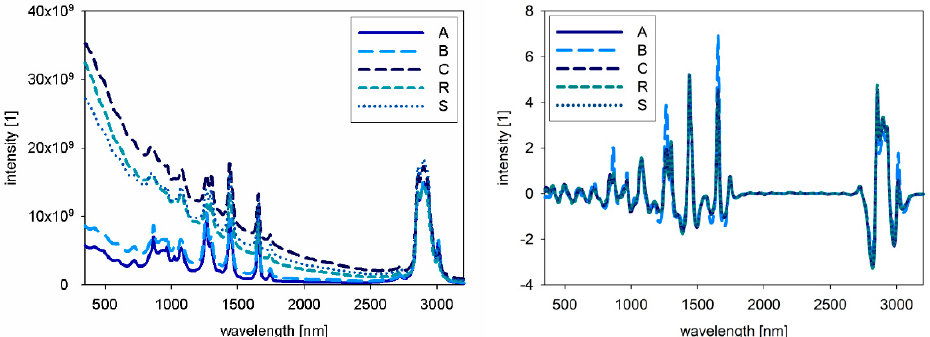
Figure 3. Raman spectra of native oils, A: chia, B: chia, R: rape seed, S: sunflower, C: corn, raw spectra ( left ), pre-processed spectra ( right ).